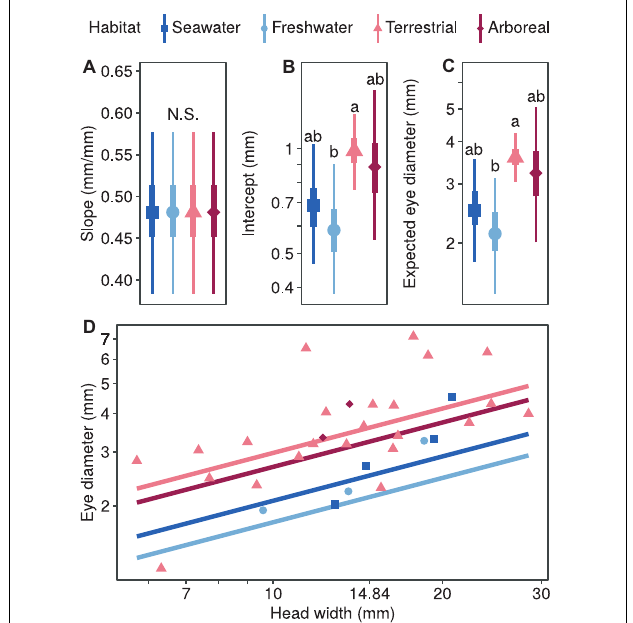
FIGURE 2 | Comparison of growth patterns of eye diameter and head width for different taxa, including allometric growth index (A) , proportionality coefficient (B) , expected eye diameter (C) and scatter diagram (D) . In subplots (A–C) , the symbols, vertical thick lines and vertical thin lines indicate the median, 50 and 95% HDI of the posterior distribution, respectively, and lowercase letters indicate multiple comparisons between groups (not having the same letter indicates a significant difference), while N.S. indicates no statistical difference. In (D) , the points indicate the mean head width and eye diameter within each species.